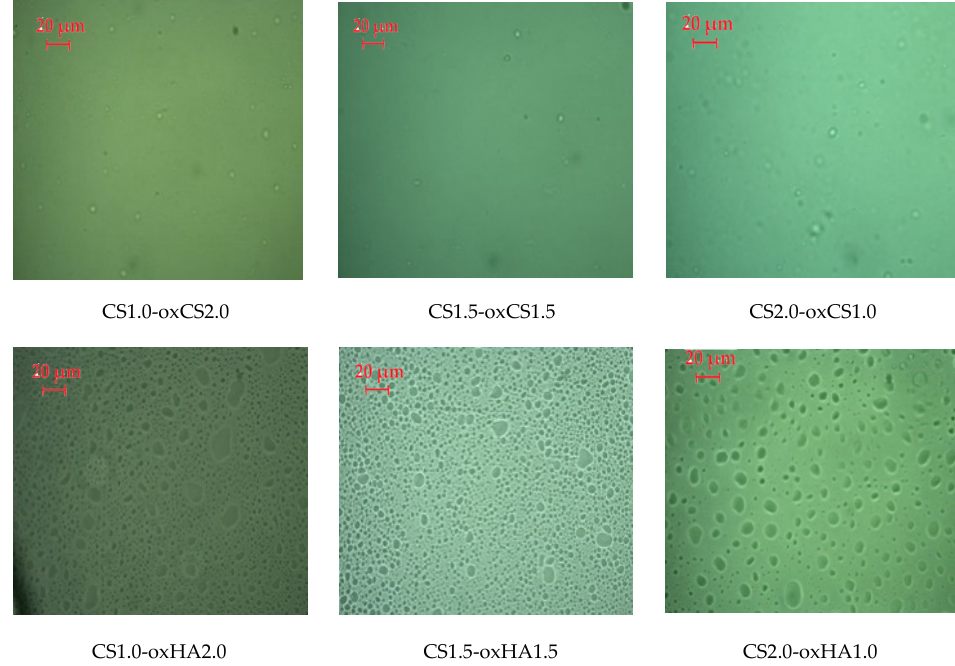
Figure 2. The microscopic aspect of CS-oxCS/oxHA hydrogels (40×).